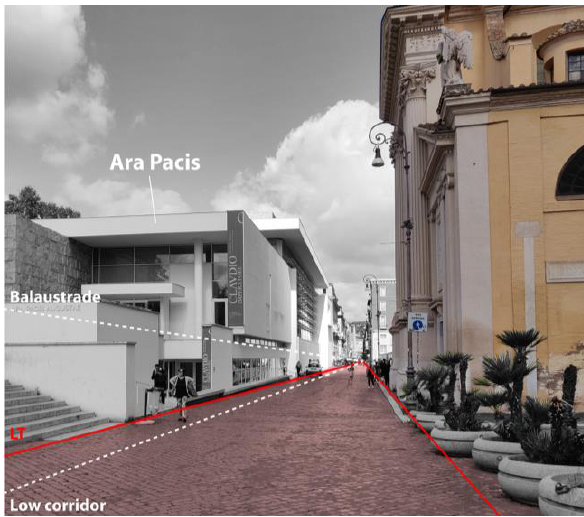
Figure 3. Road section with walking plane (in red) and two photogrammetric lines of view from the balustrade and the underground corridor beside Ara Pacis